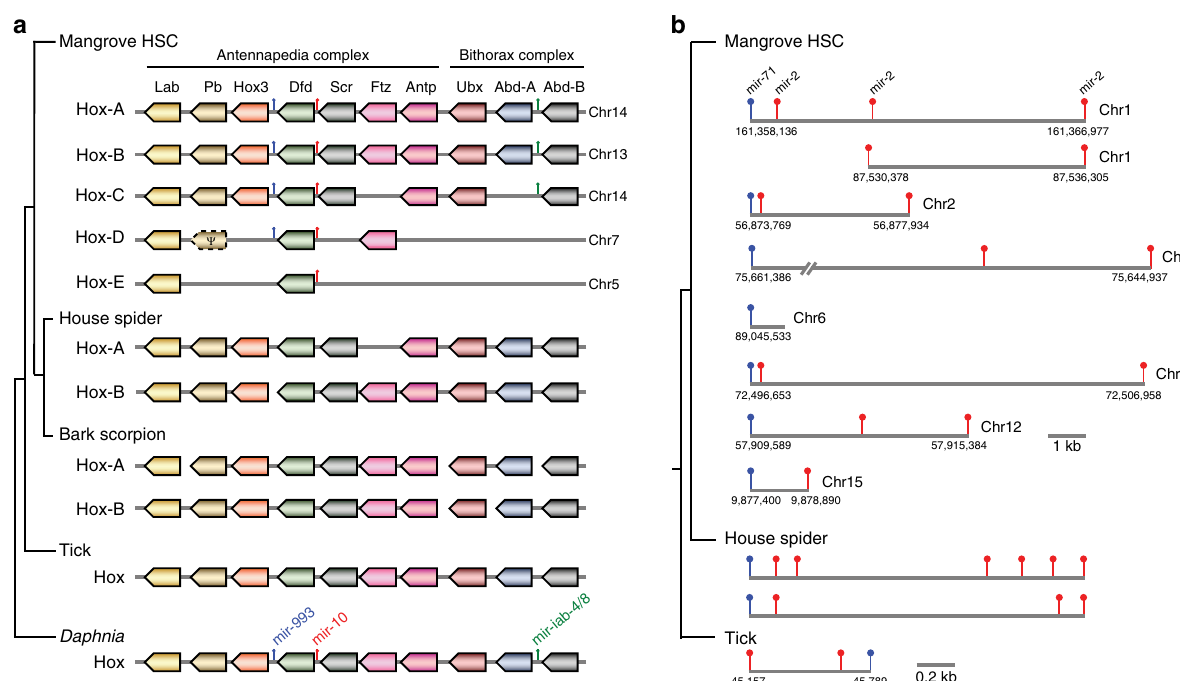
Fig. 3 Gene clusters in the mangrove HSC genome. a Hox gene clusters in the mangrove HSC compared to those in house spider, bark scorpion, tick, and Daphnia . The positions of four miRNAs ( mir-993 , mir-10 , mir-iab-4 , and mir-iab-8 ) are also shown, the latter two being located at the same position but on opposite strands. b miRNA mir-71 and mir-2 gene loci in the mangrove HSC genome. House spider and tick miRNA gene loci are shown for comparison. The house spider miRNA loci are not drawn to